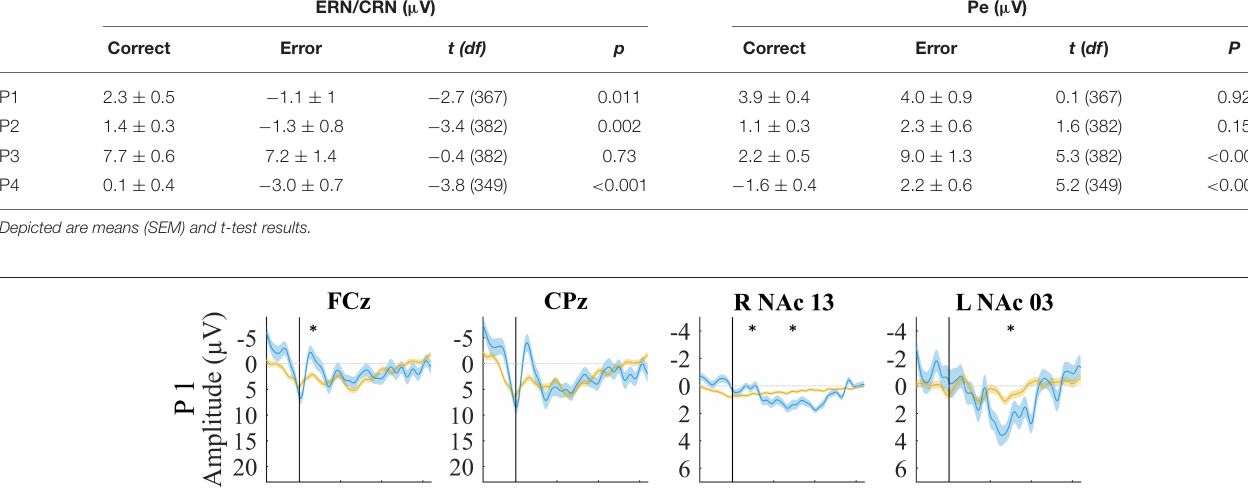
TABLE 2 | Amplitude measures of the error-related negativity (ERN)/correct-related negativity (CRN) at FCz and the error positivity at CPz. ERN/CRN ( µ V) Pe ( µ V) Correct Error t (df) p Correct Error t ( df ) P